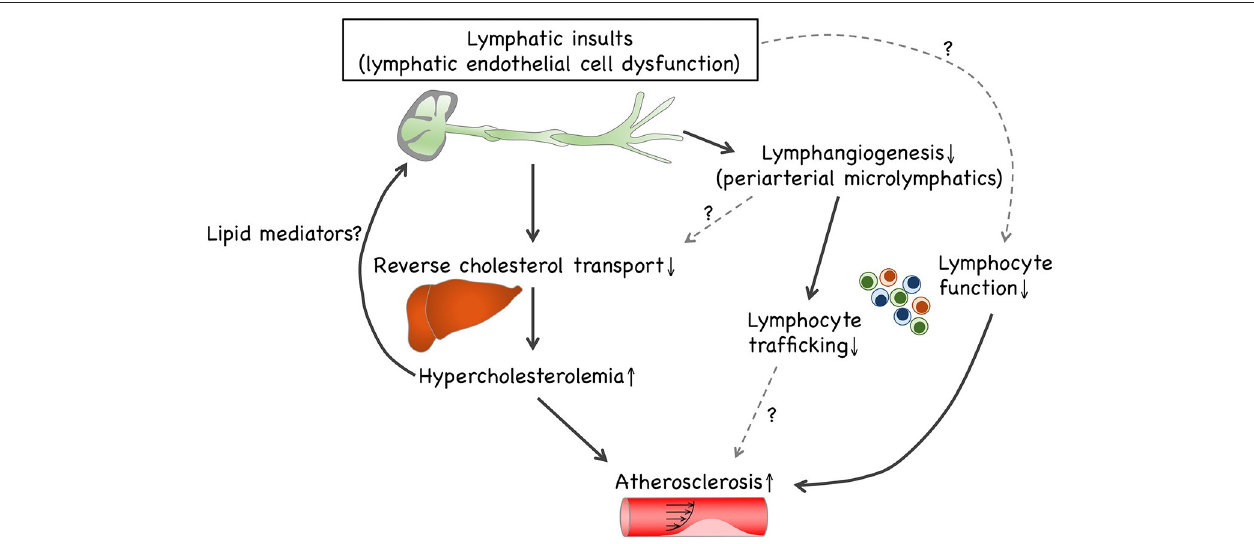
FIGURE 1 | Causal relationship between lymphatic insults and hypercholesterolemia. Lymphatic insults under hypercholesterolemic conditions are likely to interrupt reverse cholesterol transport, which can be owed to the turbulence of lymphatic drainage within collecting lymphatic vessels and to impaired lymphangiogenesis involving periaortic microlymphatics. Additionally, lymphangiogenesis is disrupted under hypercholesterolemic conditions independently of VEGF-C and VEGF-D depletion. Such lymphangiogenic insufficiency can be responsible for limited lymphocyte trafficking. LECs enable exerting antigen presentation to modulate dendritic cells and T cells, thereby modifying adaptive immunity. Therefore, hypercholesterolemic lymphatic insults presumably cause lymphocyte dysfunction that accelerates atherosclerosis progression. In addition, several dyslipidemic lipid mediators, such as lysophospholipids, enable modification of lymphatic patterning and functions. Since cholesterol-lowering trials reportedly recover hypercholesterolemic lymphatic insults, it is possible that hypercholesterolemia can precede lymphatic insults, presumably owing to lipid mediators.